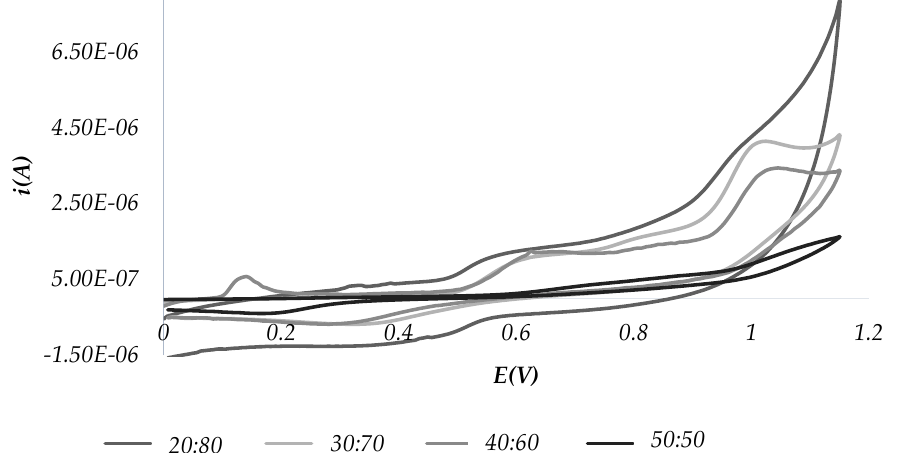
Figure 2. CV scans recorded, varying the oil: graphite ratio in the CPE.